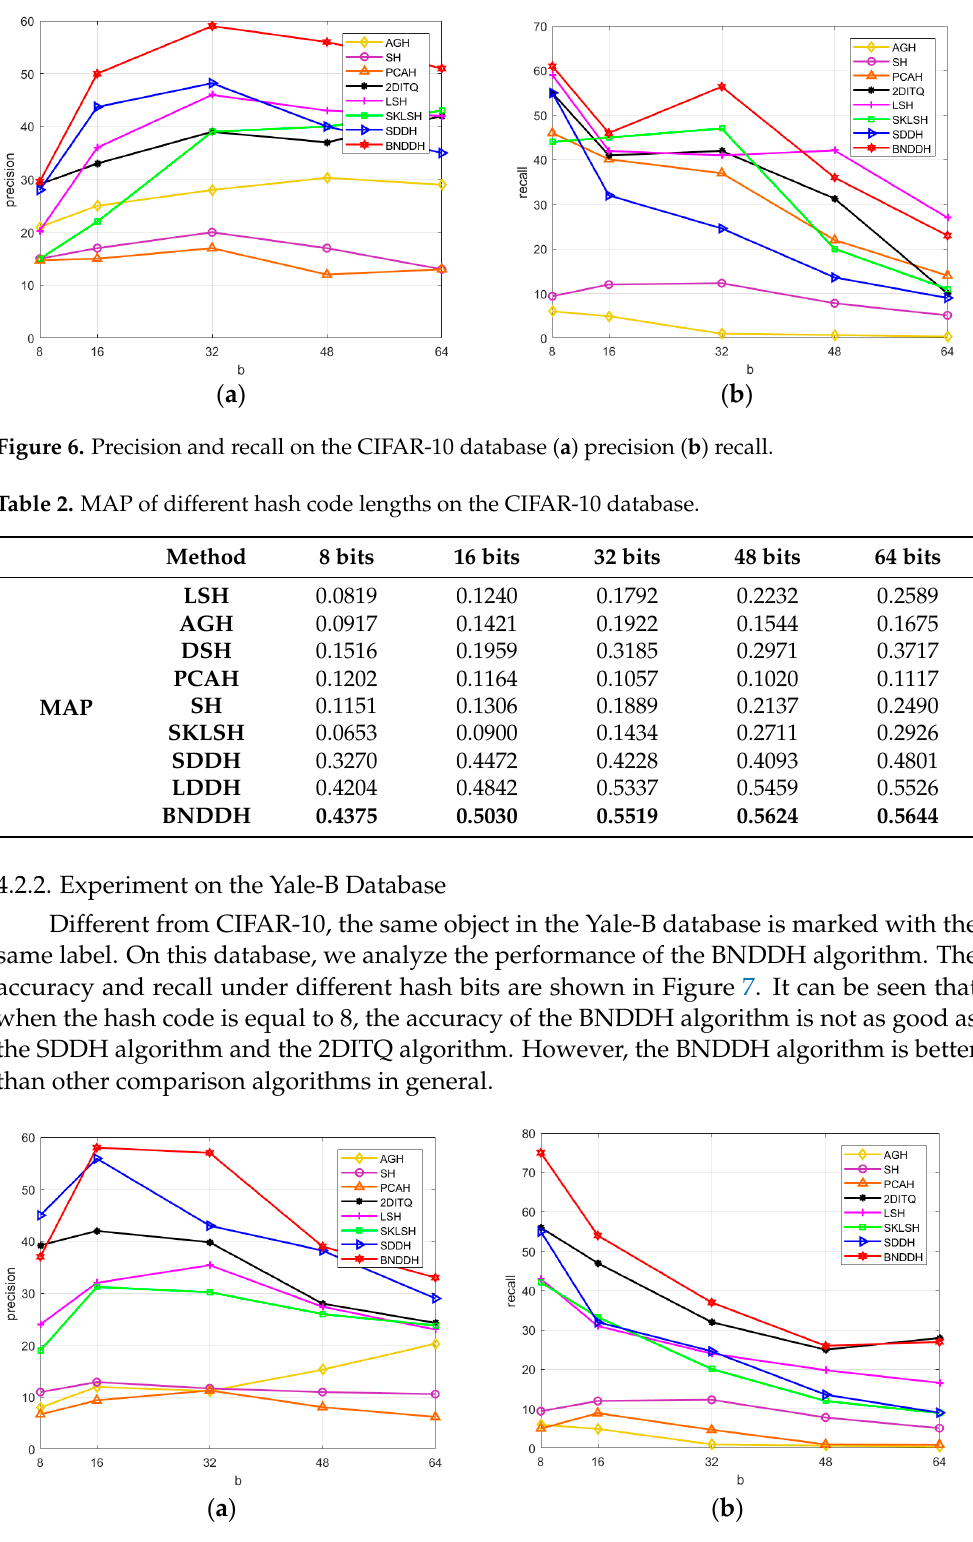
Figure 7. Precision and recall on the Yale-B database ( a ) precision ( b )